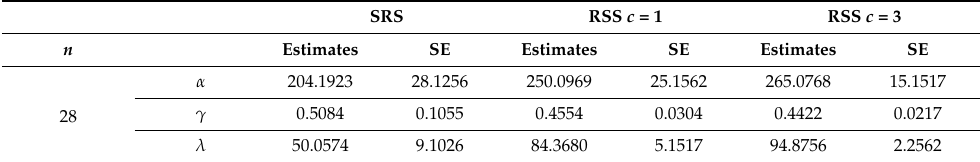
Table 18. MLE for the SRS and RSS of the carbon fibre